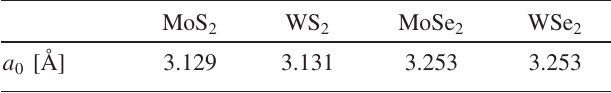
TABLE X. DFT-LDA lattice